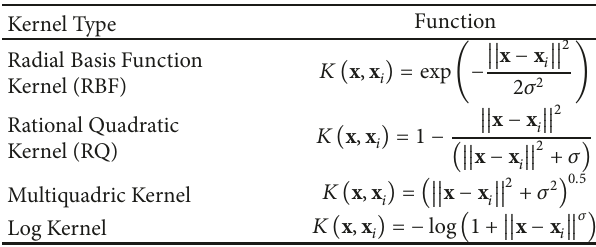
Table 3: Type and functions of four existing kernel